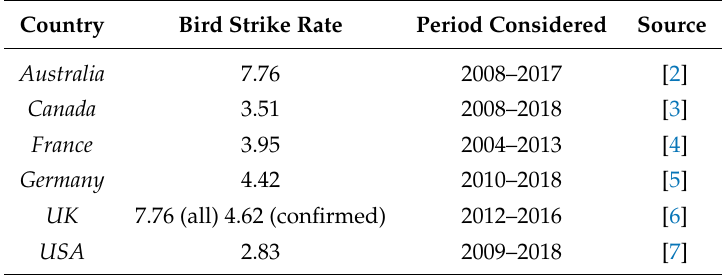
Table 1. Average bird strike rates (number of strikes per 10,000 aircraft movements) for different